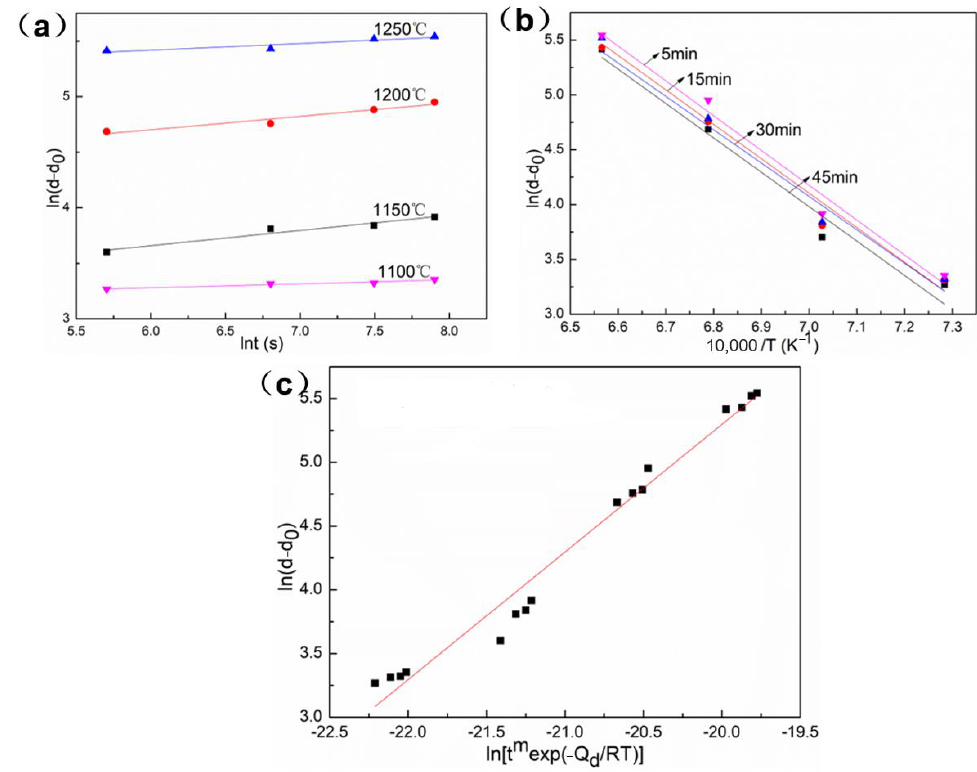
Figure 7. The linear fitting relationship of different parameter combinations: ( a ) lnt − ln(d − d 0 ), ( b )1000/T − ln(d − d 0 ), ( c ) ln[t m exp( − Q d /RT)] − ln(d − d 0 ).